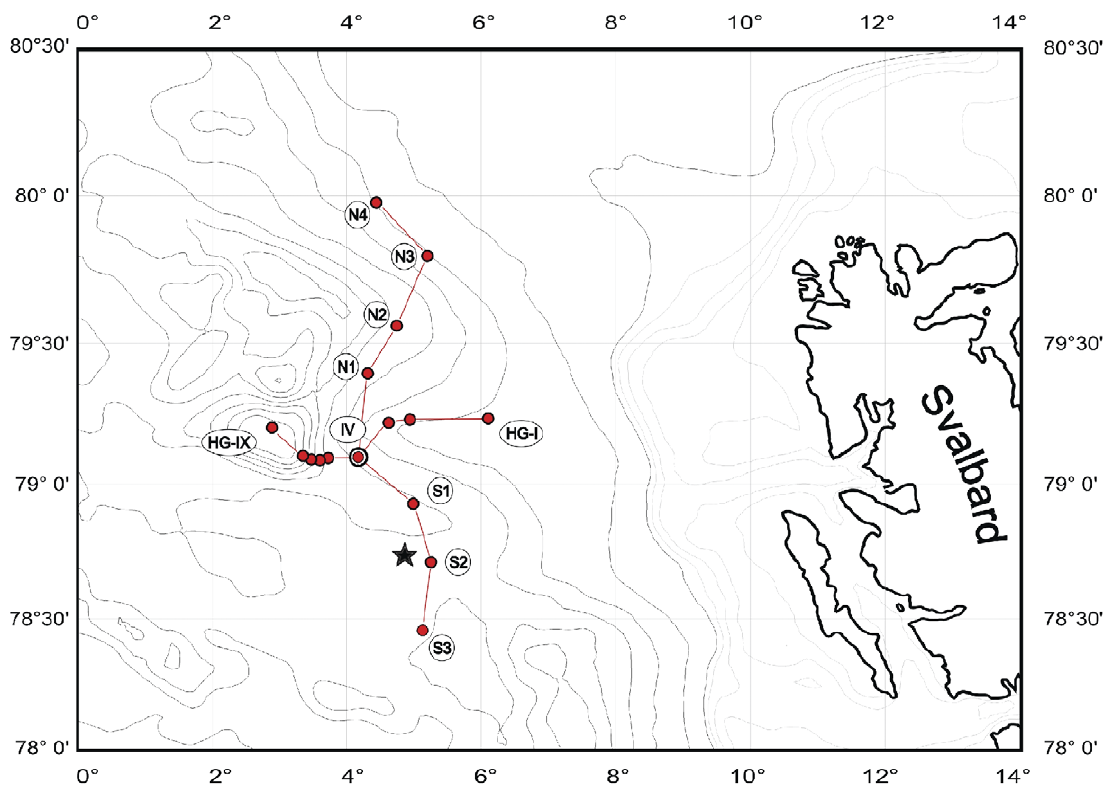
Figure 1. Location of HAUSGARTEN observatory. Bathymetric map of the HAUSGARTEN area with 16 permanent sampling sites (red dots). The star marks the sampling position of this study at 2300 m water depth.